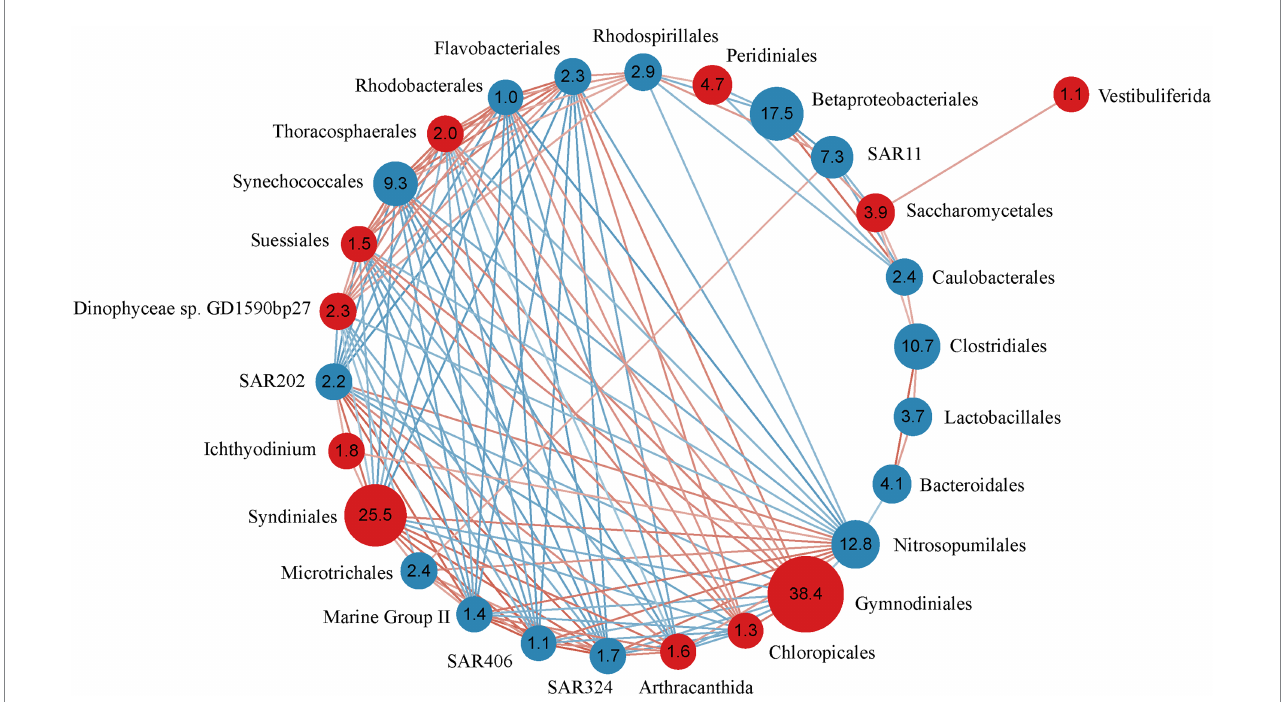
FIGURE 3 Correlation relationship with the order (relative abundance of >1%) comprising bacteria and microeukaryotes across 43 samples. The network shows strong ( R = 0.4) and significant ( p < 0.05) Spearman rank correlation coefficients. Red circles represent microeukaryotic orders, blue circles represent bacterial orders. Numbers in the circles are the relative abundance of bacterial/microeukaryotic orders. Red lines indicate positive correlations, blue lines indicate negative